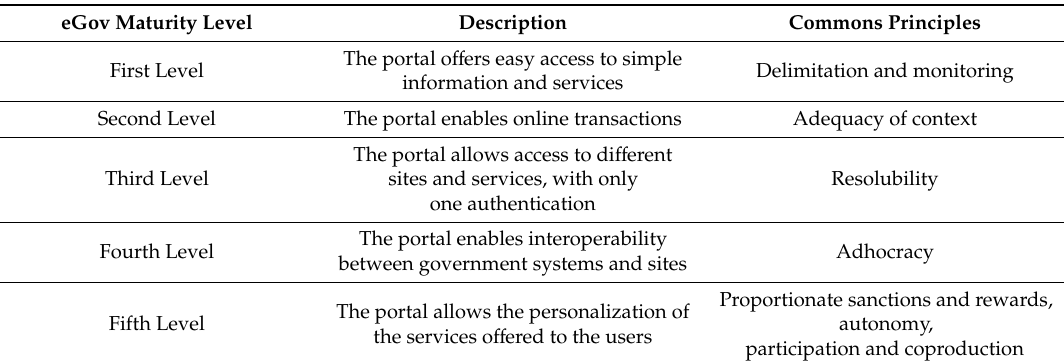
Table 3. Relationship between eGov maturity levels and commons